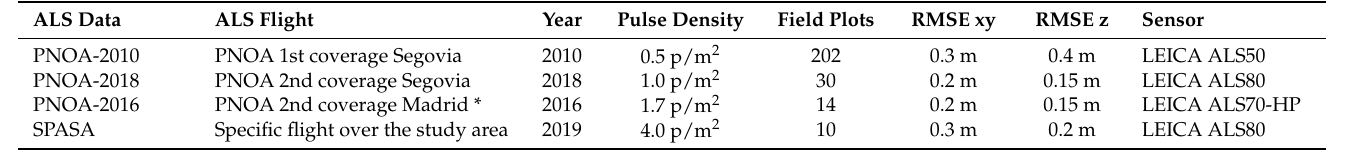
Table 1. ALS data available and corresponding field plots in the study area, including horizontal (RMSE xy) and vertical (RMSE z) accuracy. RMSE, root mean square error. Year Pulse Density Field Plots RMSE xy RMSE z Sensor